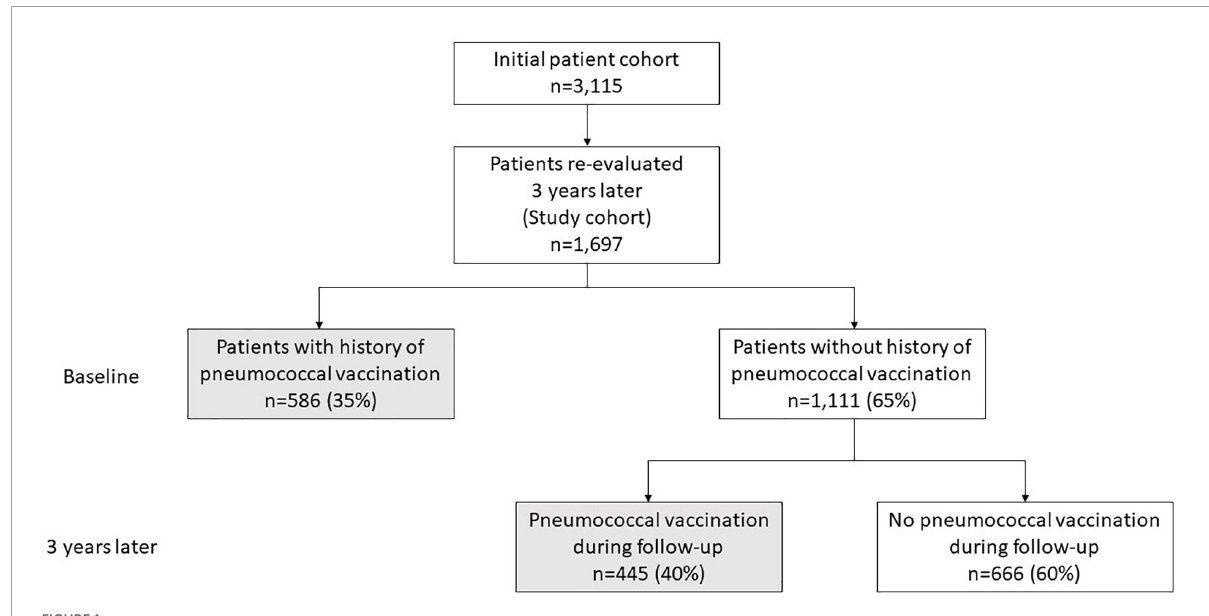
FIGURE1 Flow chart of vaccination